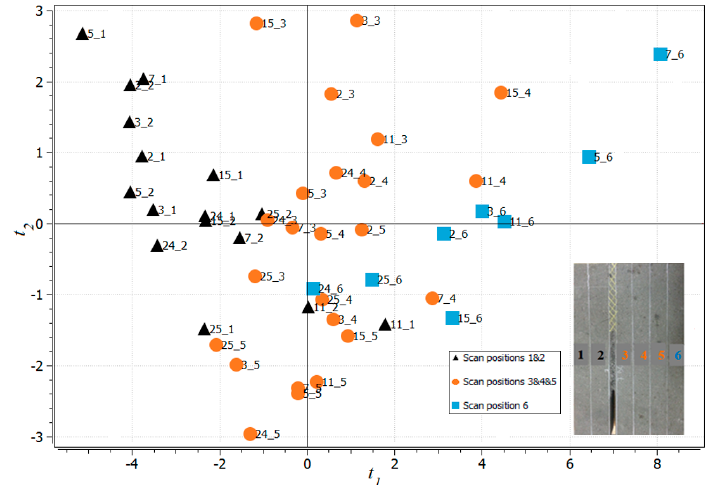
Figure 7. Score plot of the Partial Least Squares (PLS) model ( t 1 – t 2 ) between acoustic attenuation and X-ray image textural features. Observations are identified by the slice number (red numbers in Figure 1) followed by the corridor number (1–6). Different colors are used to distinguish the different corridors as shown in the anode slice image included in the